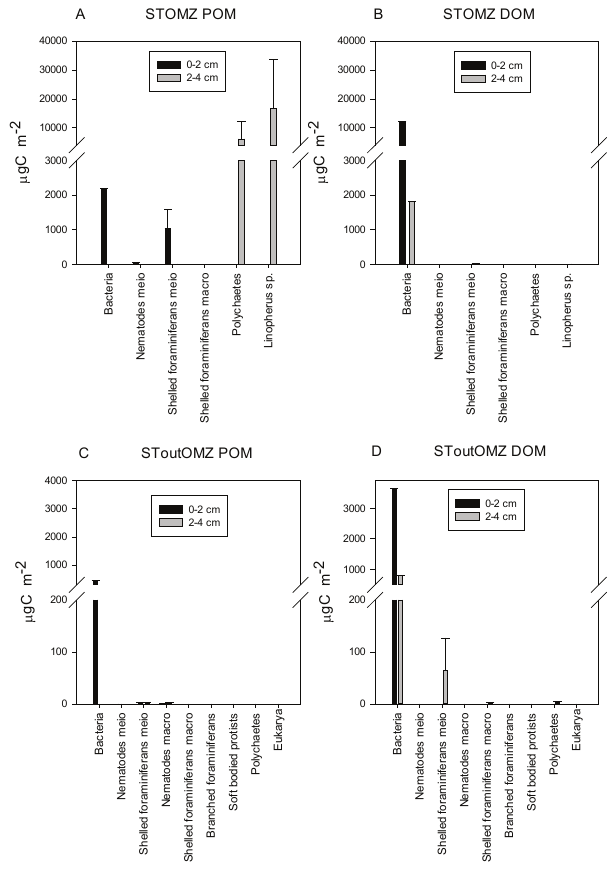
Fig. 3. Total tracer C incorporation in the stations divided per treat- ment. The term “Soft bodied protists” represents gromiids and al- logromiids. “Polychaetes” regroup all polychaete species other than Linopherus sp., “Eukarya” regroup all other faunal groups besides nematodes, foraminifera and polychaetes, for which no determina- tion was